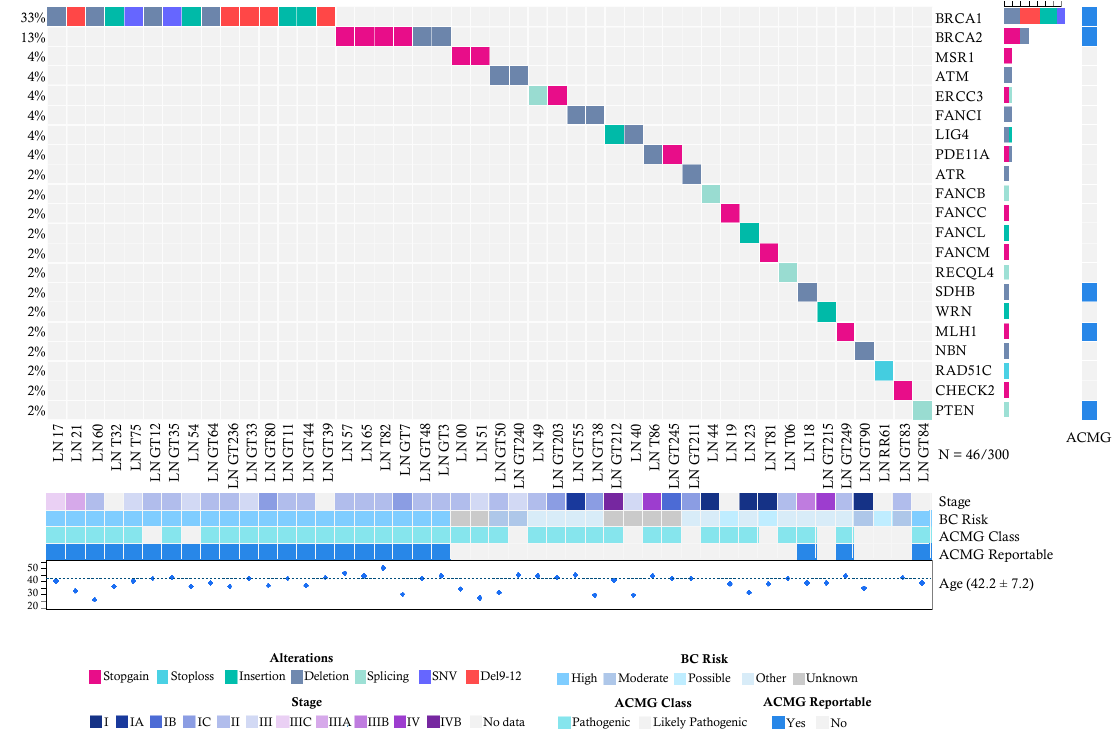
Figure 1. Allelic distribution of the pathogenic variants in patients with cancer. The grid panel depicts the pathogenic mutations found in each patient color-coded for each type. Right panel: gene reportable by the suggestion of the ACMG (light blue = yes, gray = no). Bottom axis: patient ID. Left axis: relative frequency of mutations per gene. Right axis: mutated gene. Right bar plot: absolute frequency and type of pathogenic mutation per gene. Bottom panel indicates: stage (I-IVB); risk associated with a pathogenic variant; ACMG variant class (pathogenic, likely pathogenic); gene reportable by the suggestion of the ACMG (light blue = yes, gray = no); age distribution.